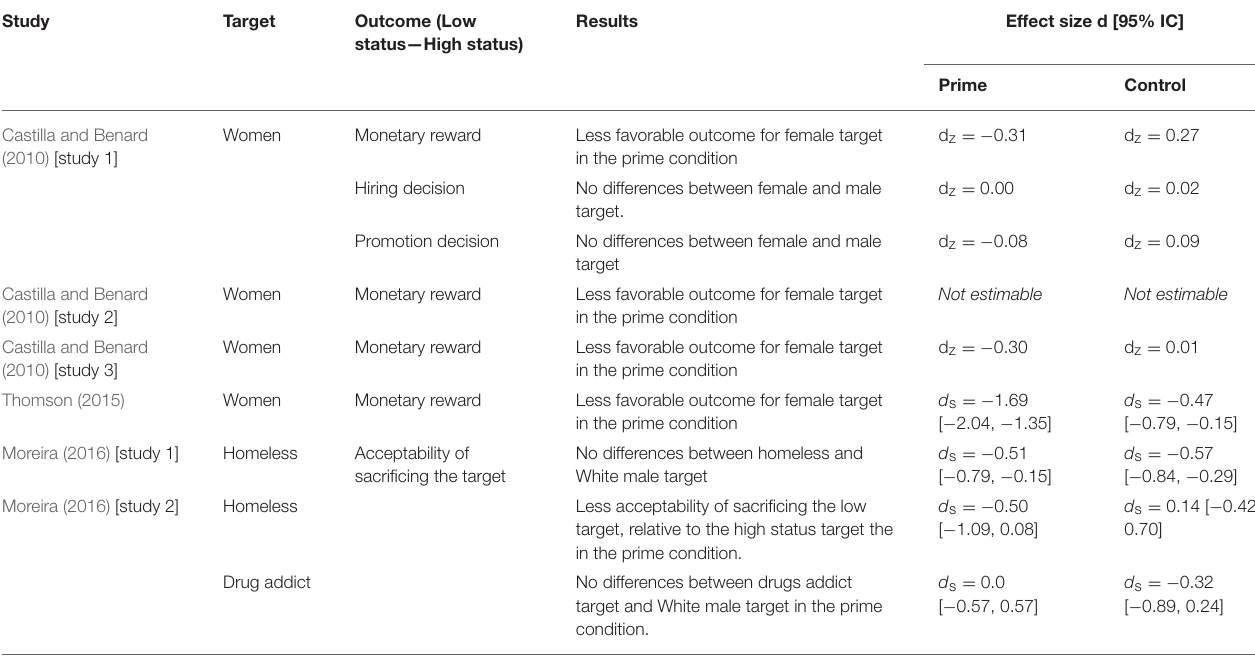
TABLE 6 | Summary of studies related with the Impact of Meritocracy and Decisions toward Low and High Status Targets. Study Target Outcome (Low Results status—High status)